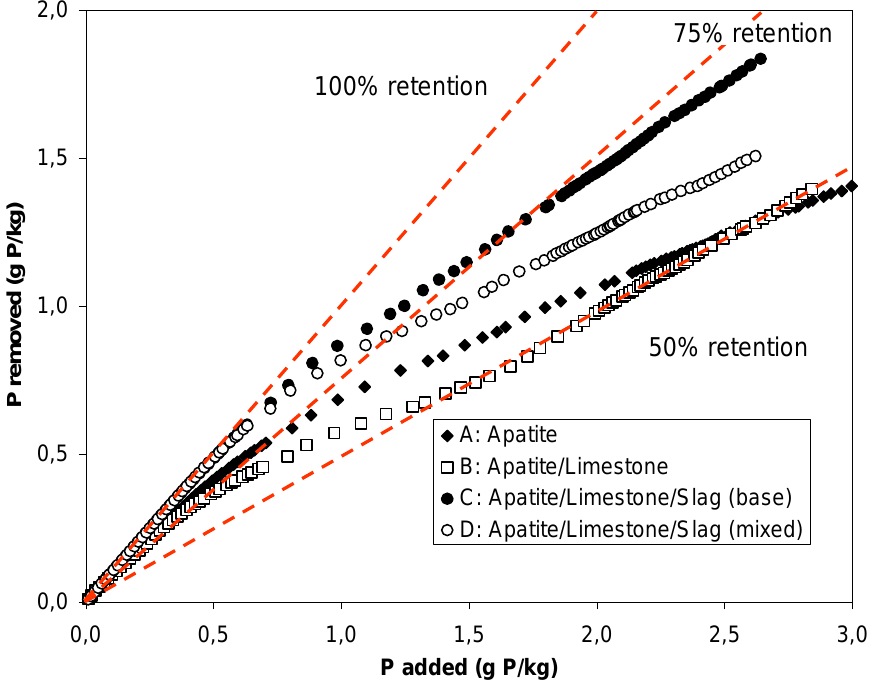
Figure 3. P removed as a function of P added.